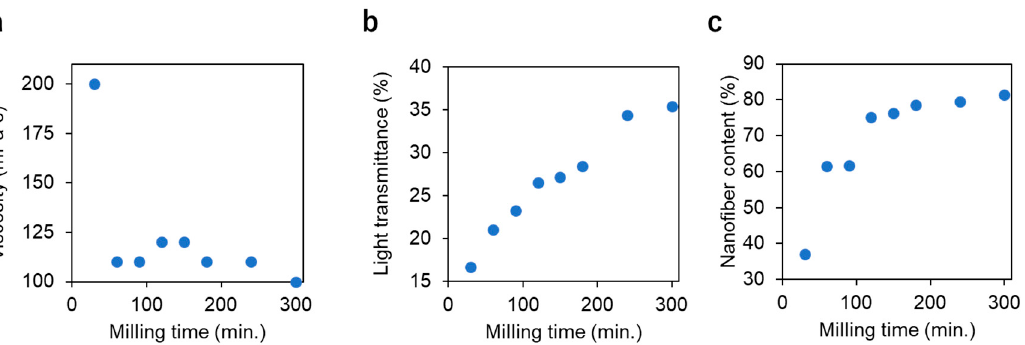
Figure 8. ( a ) Viscosity, ( b ) transmittance at 600 nm, and ( c ) nanofiber yield after milling of chitin with different milling times.